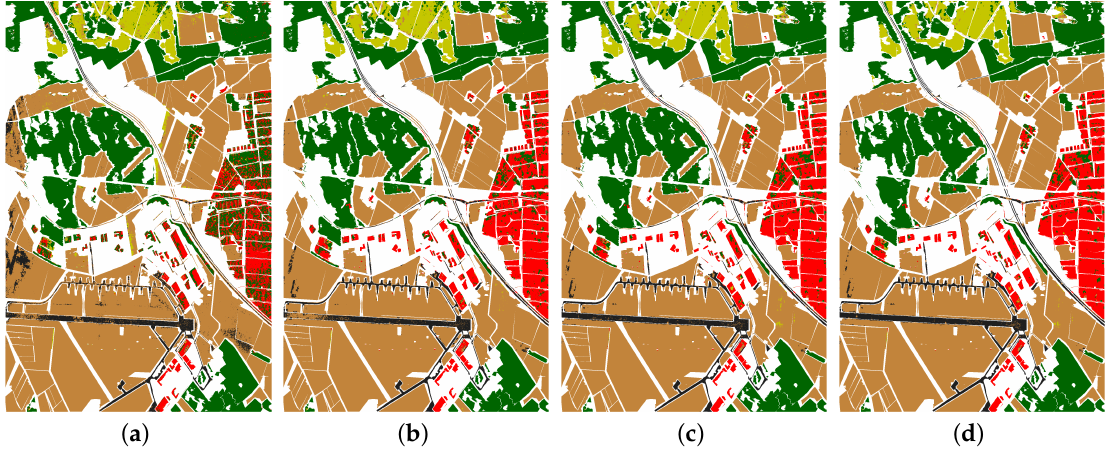
Figure 9. Influence of region and patch-based features: TGR1 (single-pixel features), TGR2 (single-pixel features augmented with intensity-based region features), TGR3 (single-pixel features augmented with 2-D patch features), TGR4 (single-pixel features augmented with all region and patch features). ( a ) TGR1, BA = 74.4%; ( b ) TGR2, BA = 86.2%; ( c ) TGR3, BA = 89.3%; ( d ) TGR4, BA =